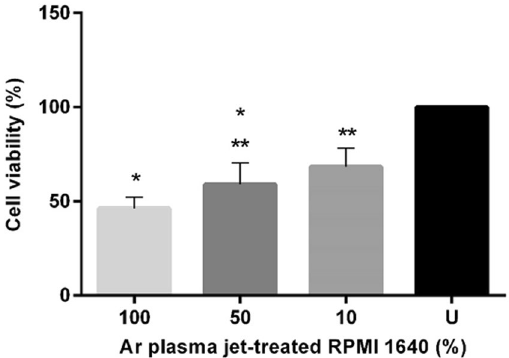
Figure 5. Percent cell viability (determined with the resazurin assay) after 48 h incubation in untreated (U) RPMI 1640 and Ar plasma jet-treated RPMI 1640 (at concentrations of 10, 50 and 100%). Each point represents the mean value and ± standard error of the mean (SEM) of samples analyzed in triplicate ( n = 3). One-way ANOVA was used to determine the statistical significance of the values. The values without a mark above indicate that they are significantly different whereas the values sharing * or ** are not ( P < 0.05).